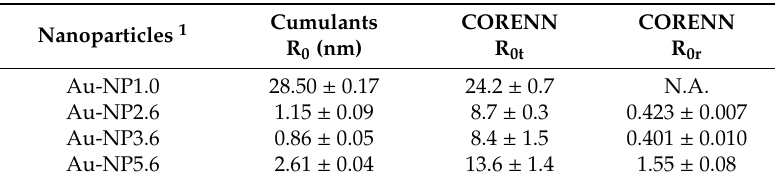
Table 2. Hydrodynamic radii of gold nanospheres and gold nanorods, as obtained from the analysis of intensity size distributions: extrapolations for the zero concentration limit by linear regression, based on Cumulants and CORENN method. For nanorods the hydrodynamic radii of translation, R 0t , and rotation, R 0r , were calculated with the CORENN method [9].